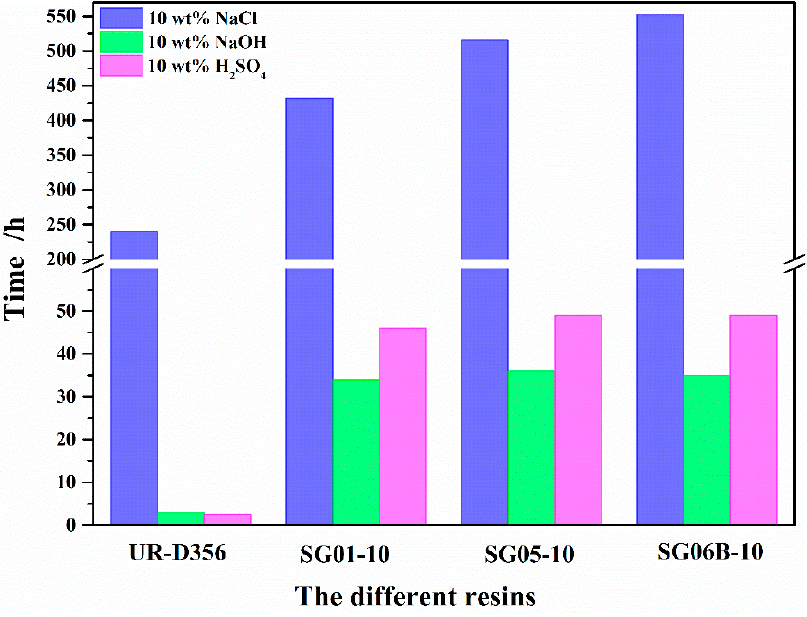
Figure 12. The bubble time of different resins after being dipped in salt, alkaline, and acid solution.